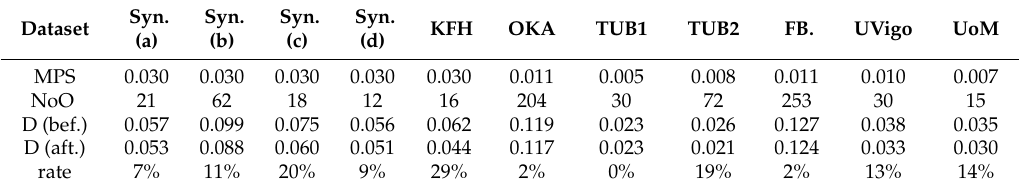
Table 3. Geometric quality of the reconstructed